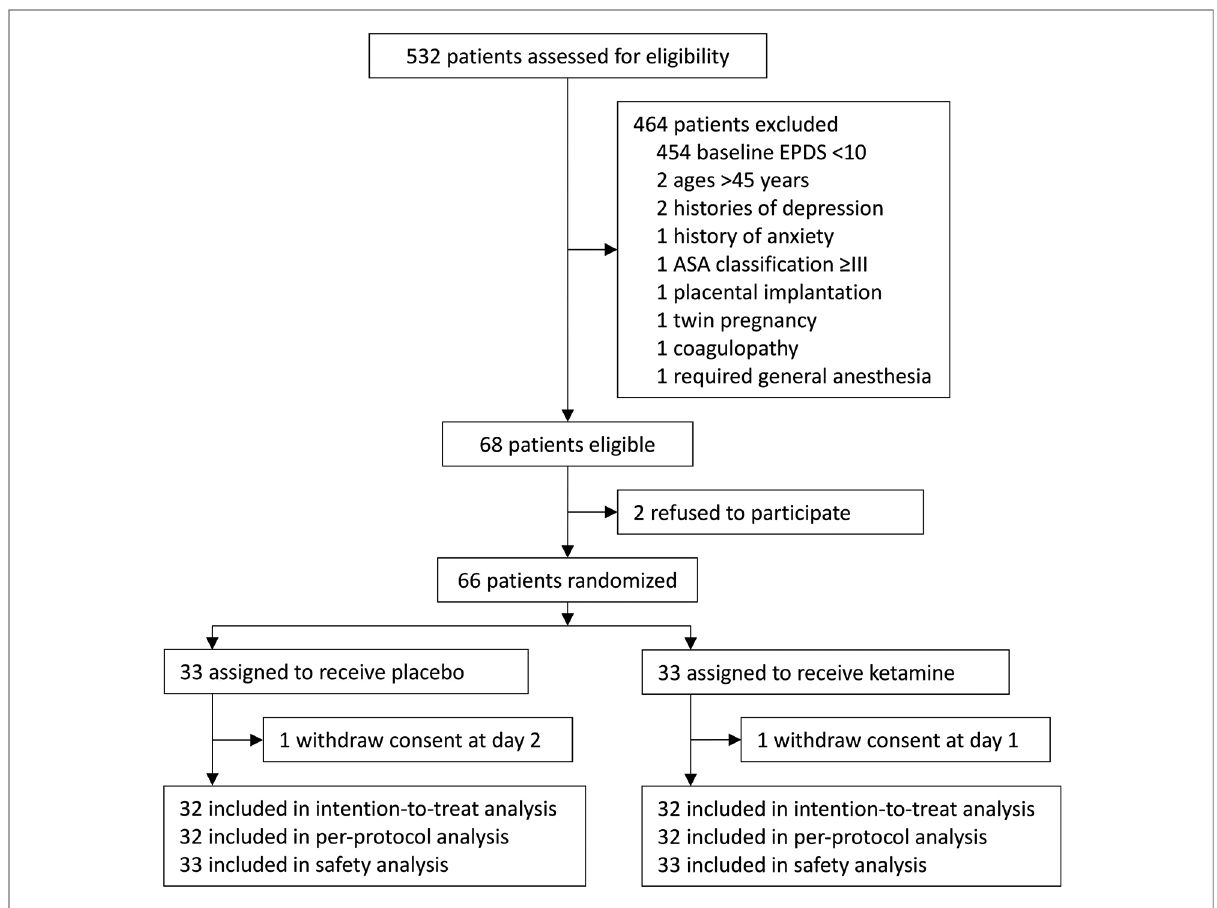
FIGURE 1 Flowchart of the trial. EPDS, Edinburgh Postnatal Depression Scale; ASA, American Society of